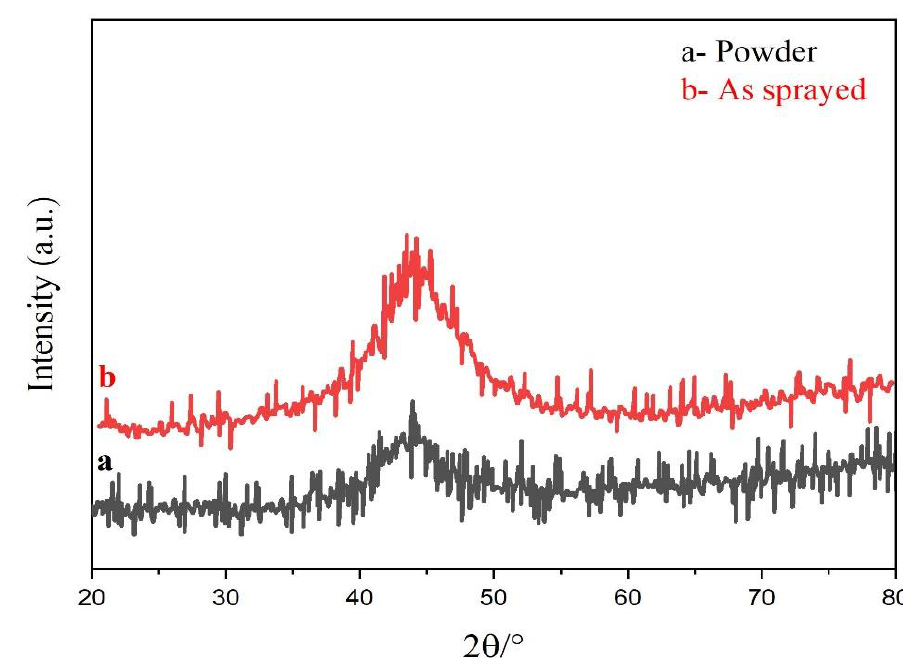
Figure 2. X-ray diffractometer (XRD) spectrum of powder and as-sprayed coating.